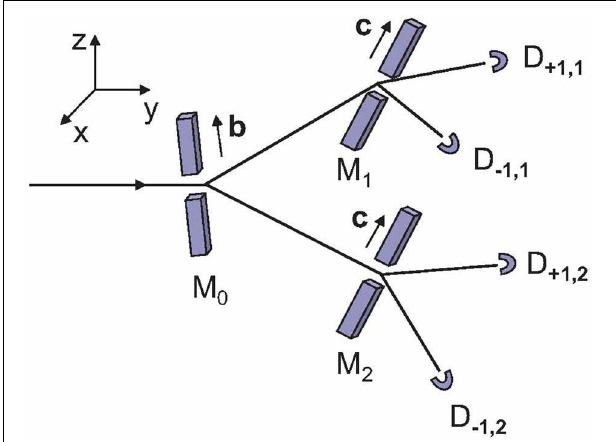
FIGURE 2 | Diagram of the filtering-type experiment of which the neutron experiment [14, 15] is a special case. Spin-1/2 particles pass through a Stern-Gerlach magnet M 0 that projects the spin onto either the b direction or the − b direction. In case of the former (latter) projection, the particle is directed to the Stern-Gerlach magnet M 1 ( M 2 ). M 1 and M 2 are assumed to be identical and project the spin onto either the c direction or the − c direction. A “click” of one of the four detectors D + 1 , 1 , D − 1 , 1 , D + 1 , 2 , and D − 1 , 2 signals the arrival of a particle.